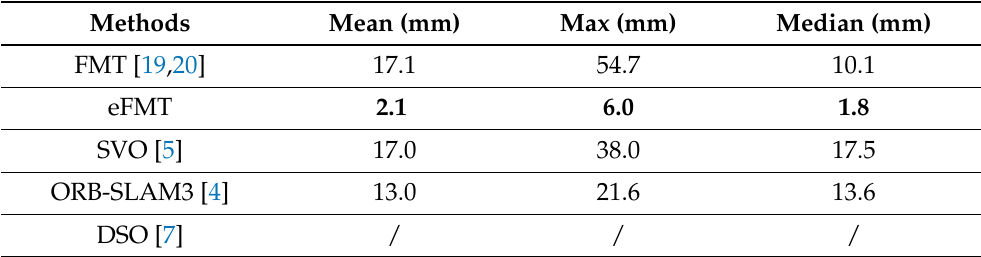
Table 2. Absolute trajectory error